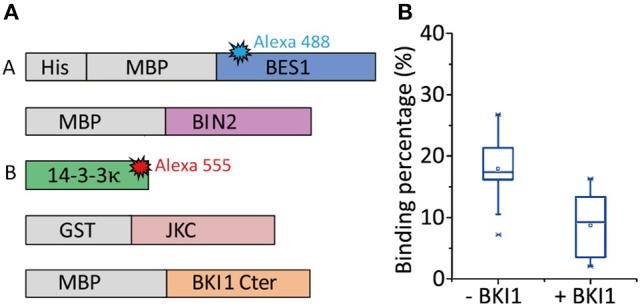
The competitive association of 14-3-3κ- with pBES1 and pBKI1 observed by CoSMoS. (A) Protein BES1 with His-tag was immobilized on slide surface. BES1 and BKI1C are phosphorylated by BIN2 and JKC, respectively, in phosphorylation buffer for 1 h at 37°C. The binding percentages of 14-3-3κ with pBES1 were observed before and after incubating with pBKI1C. (B) Binding percentage of 14-3-3κ with pBES1 before and after pBKI1C treatment. The percentage only decreased by half, from (18 ± 5)% to (9 ± 5)%, even though we used a very high concentration pBKI1C (>1,000 times larger than that of pBES1) and incubated for 1 h.